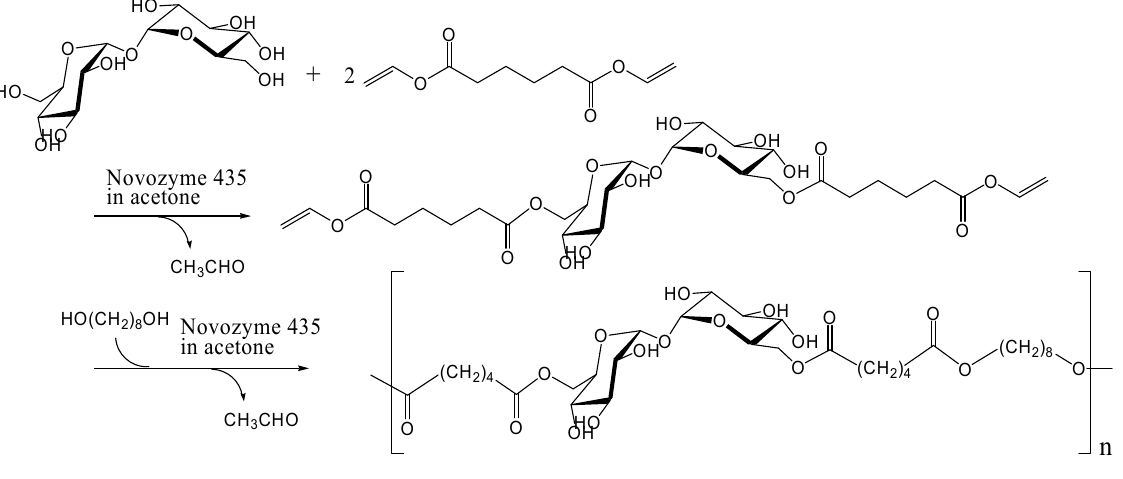
Figure 13. Enzymatic synthesis of trehalose-based